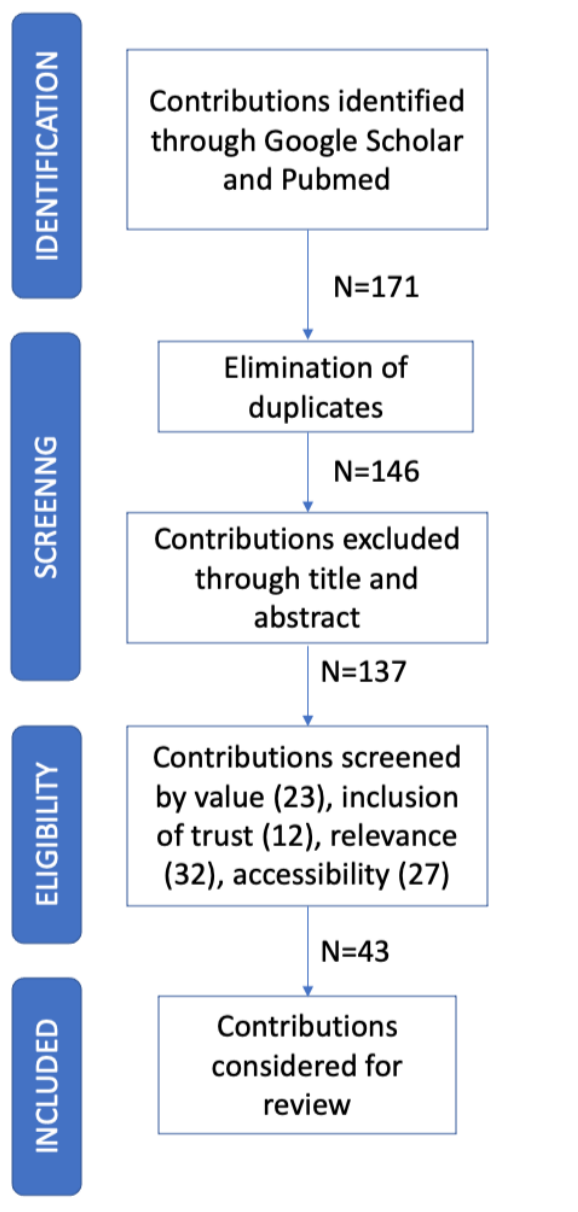
Figure 1. Flow diagram of contribution retrieval and